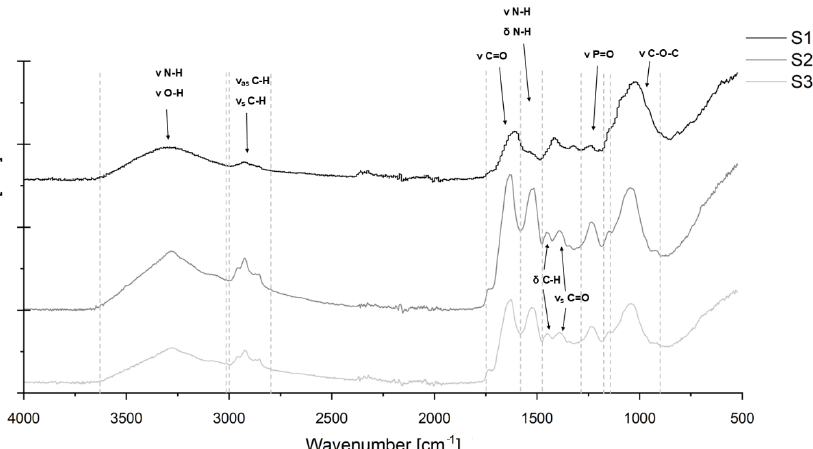
Figure 1. FTIR spectra for algae biomass wastes: S1 — Enteromorpha and Zostera Marina blend, S2 — Chlorella Vulgaris after oil extraction, and S3 — Chlorella Vulgaris before oil extraction. In the spec- tra of algae-based fillers, the specific groups for polysaccharides, lipids, and proteins were recog- nized in the range of wavenumber 2809 – 3012 cm − 1 , 1730 cm − 1 , 1425 – 1477 cm − 1 , 1389 cm − 1 , 980 – 1100 cm − 1 , and 1191 – 1356 cm − 1